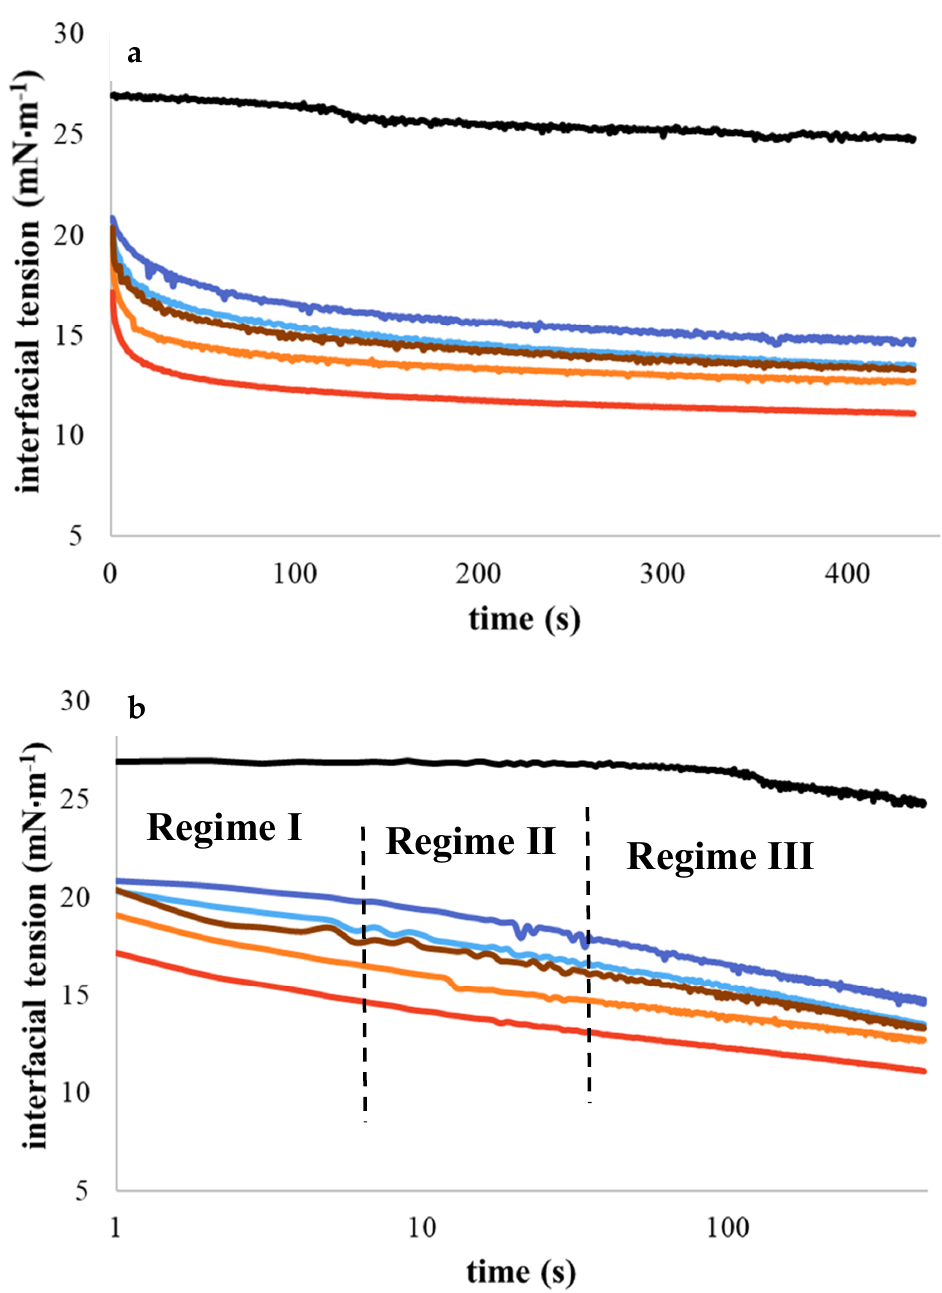
Figure 6. ( a ) Interfacial tension (mN / m 2 ) as function of time (s) for emulsions A (-), B (-), C ( - ), D ( - ), and E ( - ). ( b ) Semilogarithmic scale. Black line ( - ) corresponds to the water without proteins. A and B were obtained from Sigma and Norland, and C, D, and E from different extraction protocols.